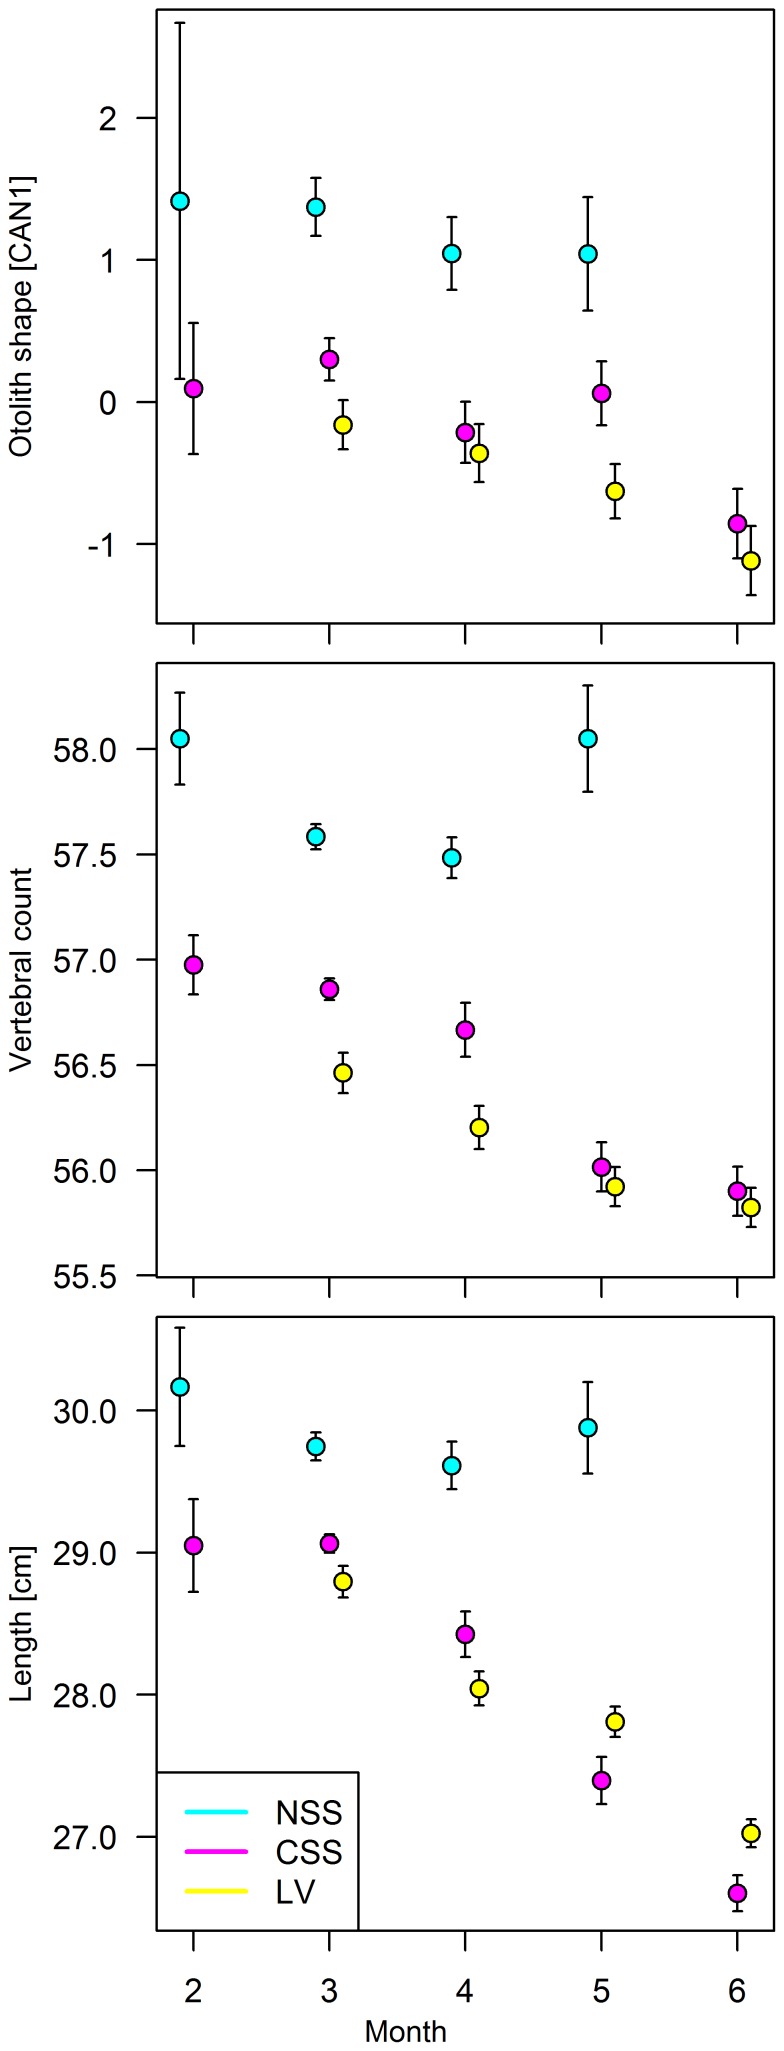
Seasonal changes of otolith shape, vertebral counts and length for different herring populations.For standardized ages. Comparison between Norwegian spring spawning (NSS), Coastal Skagerrak spring spawning (CSS) and Landvik (LV) herring (see Table 2 for N). Values given are means and standard errors (1 SE).